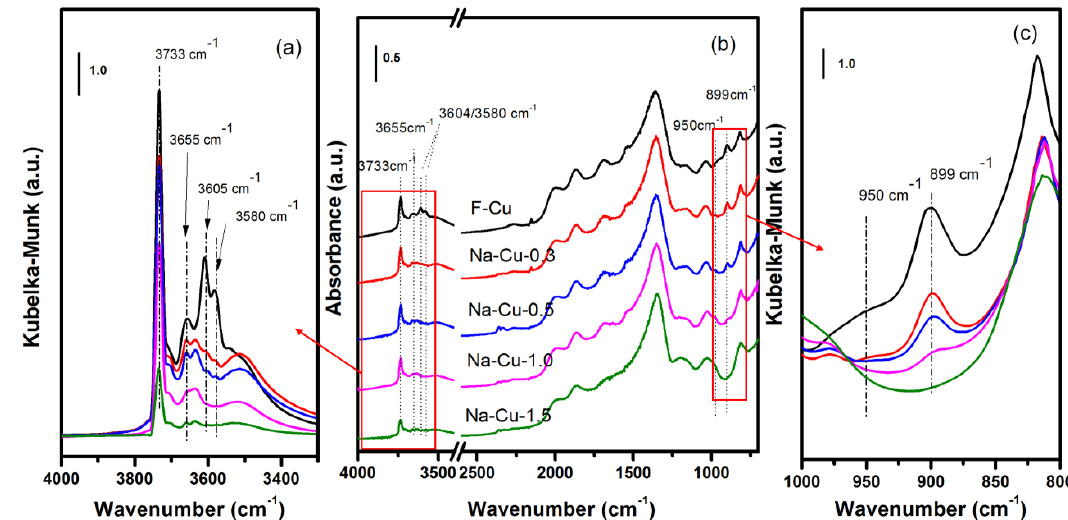
Figure 3. Ex situ DRIFTs results of fresh and Na-impregnated catalysts. Ex situ DRIFTs results between 4000 and 3300 cm −1 , units in Kubelka-Munk ( a ); ex situ DRIFTs results between 4000 and 800 cm −1 , units in absorbance ( b ); ex situ DRIFT spectra between 1000 and 800 cm −1 , units in Kubelka-Munk ( c ).